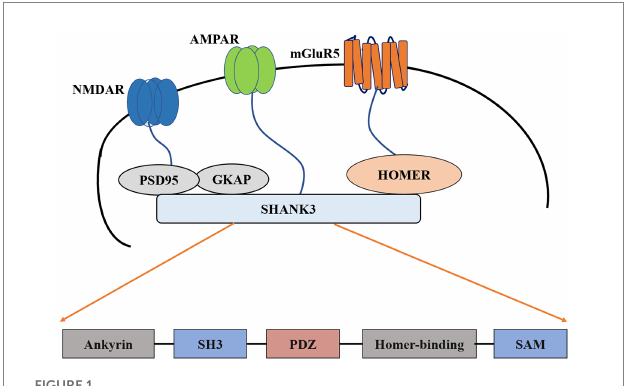
FIGURE 1 Schematic diagram of postsynaptic density and construction of Shank3. PSD-95, Postsynaptic density-95; SH3, Src homology 3; PDZ, PSD95/DlgA/Zo-1; SAM, Sterile alpha motif; mGluR5, metabotropic glutamate receptor 5; AMPAR, The α -amino-3-hydroxy-5-methyl-4- isoxazolepropionic acid receptor; NMDAR, The N-methyl-D-aspartate receptor; GKAP, guanylate kinase-associated